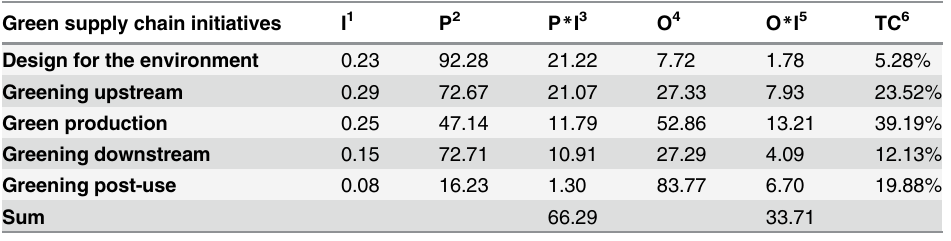
Table 12. The final ranking of green initiatives in company